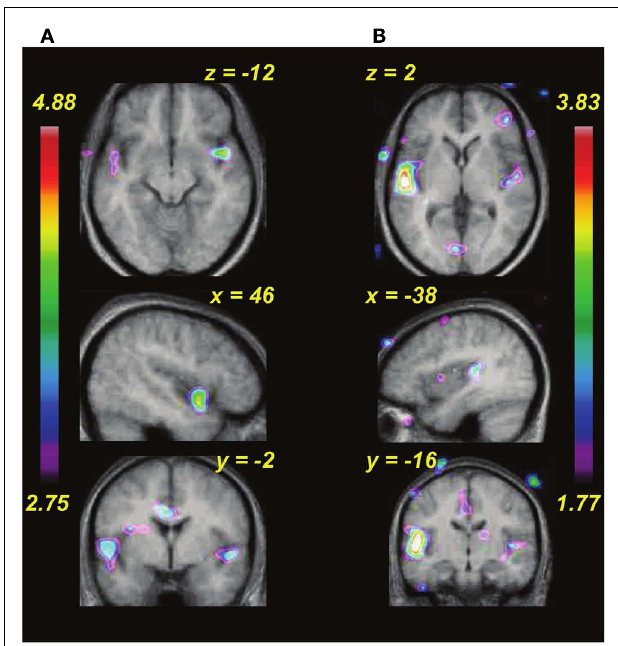
FIGURE 7 | Functional MRI data showing changes in covariation of BOLD activity with increasing pitch interval size during pre-training as a function of the individual rate of learning during training (i.e., behavioral data shown in Figure 4). (A) Passive task. (B) Active task. In both tasks, auditory cortical areas respond more to increasing pitch interval size in those individuals who subsequently showed faster learning.